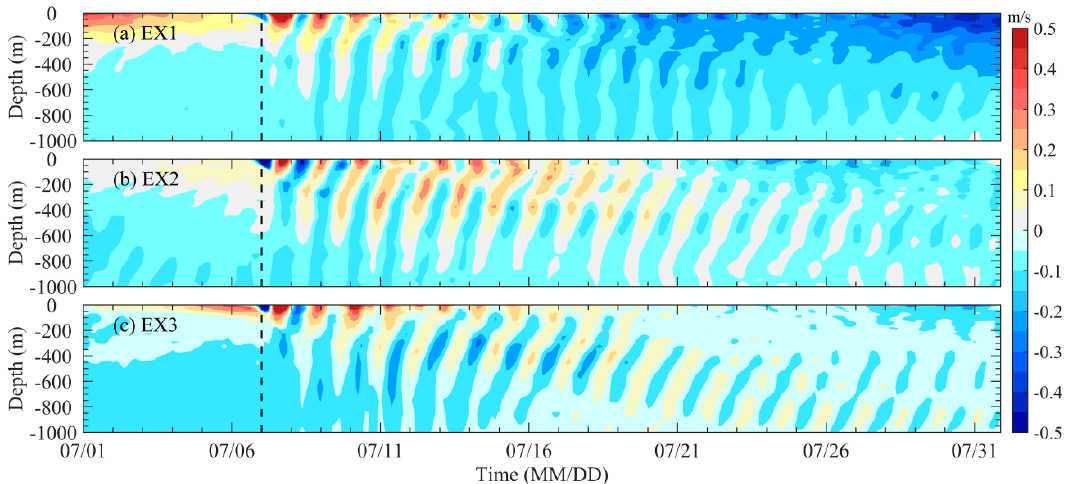
Figure 13. Time series of the zonal velocity of upper 1000 m at float 2902666 obtained from the present three numerical experiments. The black dashed line shows the time TC is closest to this point.